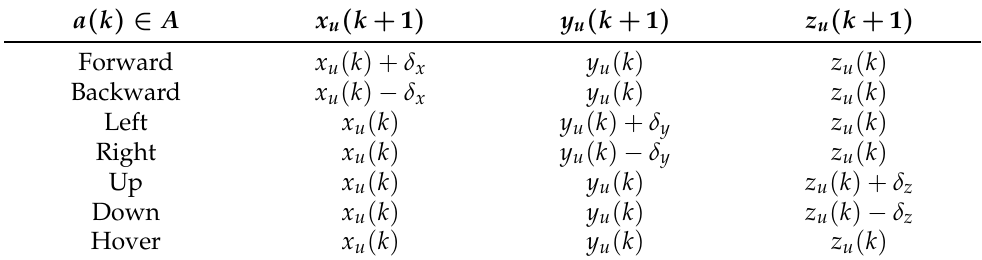
coordinate frame. The system keeps records of its current local position at time step k , and calculates δ as the change of position magnitude of coordinates x u , y u and z u from time step k to time step k +